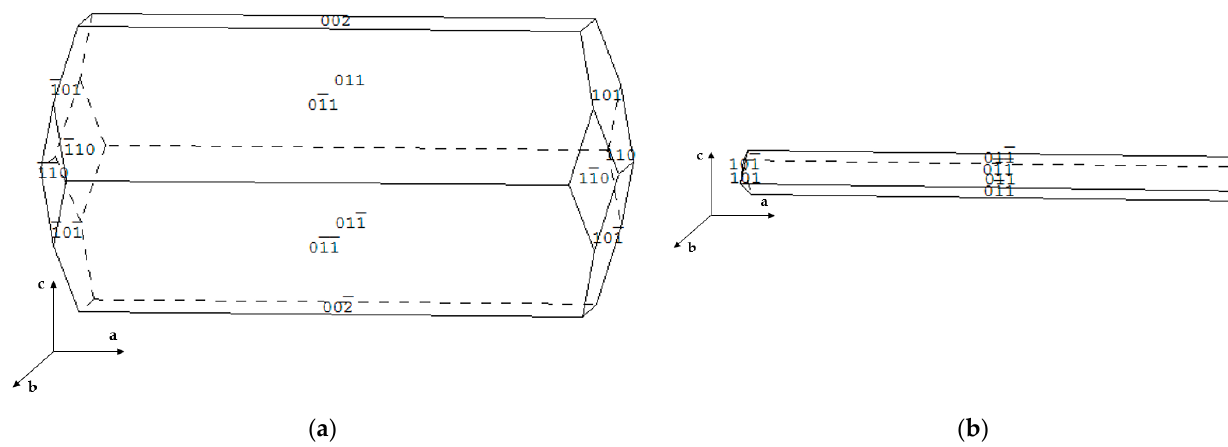
Figure 8. Calculated morphologies with BFDH model. ( a ) BFDH with distance to the central point inversely proportional to the d-spacing (1/d). ( b ) Variant of the BFDH model with distance to the central point proportional to exp(-Ad) with A = 0.4. Growth rate of {101} could be much faster resulting in a more extreme needle shape.